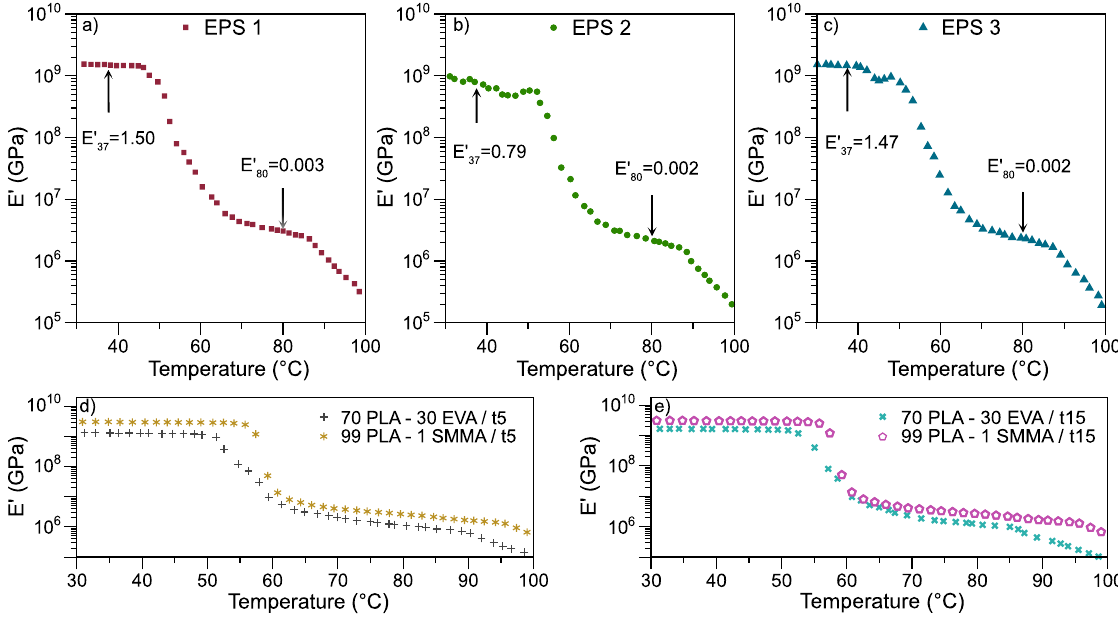
Figure 3. Thermomechanical behavior of ternary blends. ( a ) EPS 1, ( b ) EPS 2, ( c ) EPS 3, ( d ) and ( e ) binary blends.